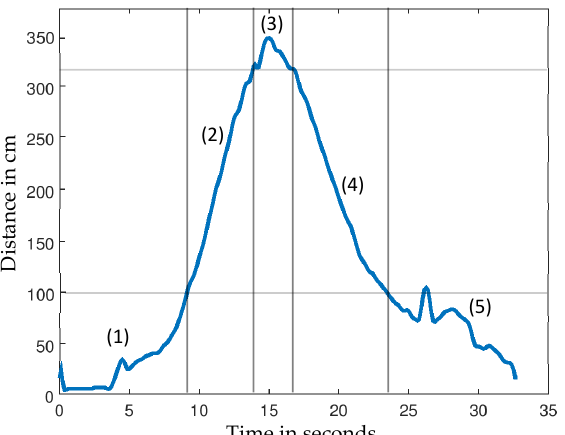
Figure 2. Example signal with the marked subtasks: sit-up ( 1 ), walk-forward ( 2 ), turnaround ( 3 ), walk-back ( 4 ), sit-down ( 5 ).